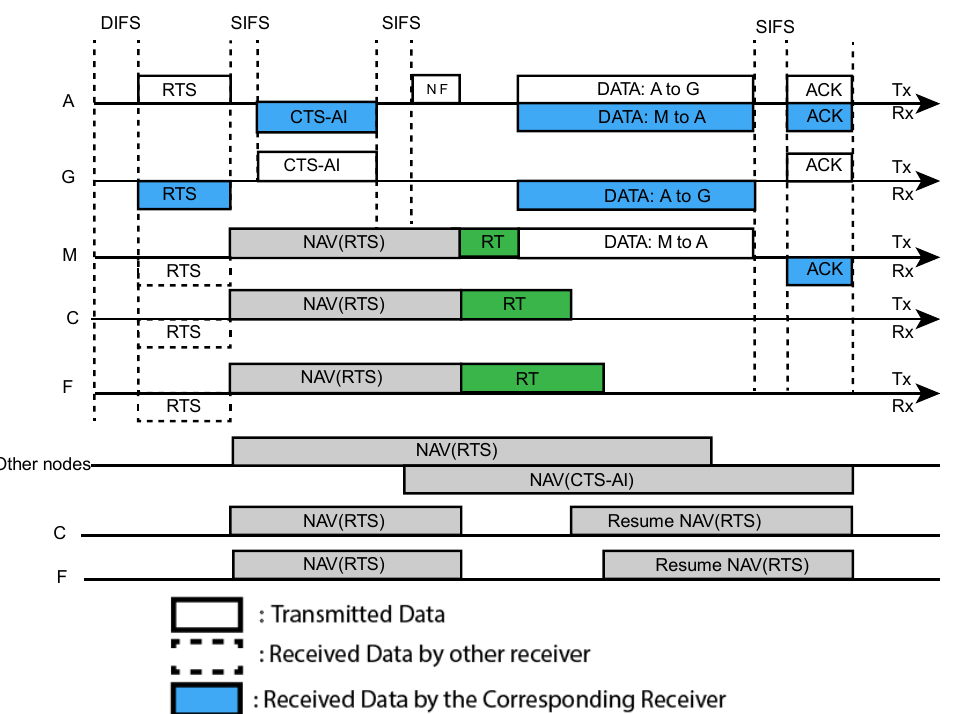
Figure 6. Time sequence of the proposed MAC for source-based TNFD (the rest of the nodes except MS initiate the transmission).